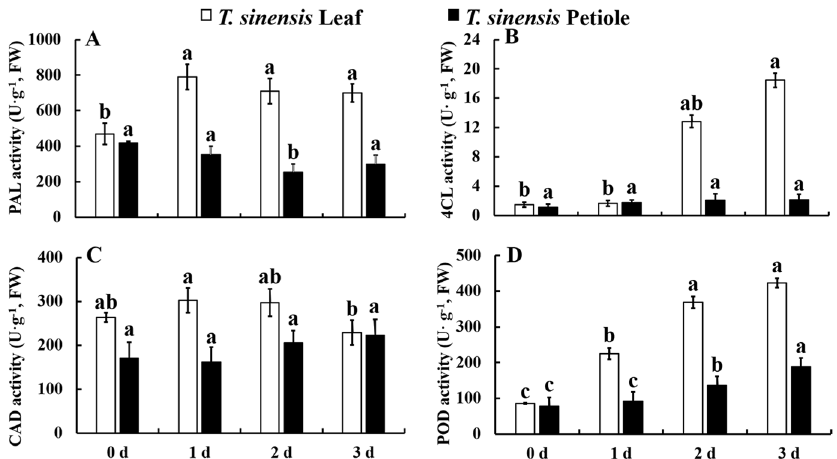
Figure 2. Analysis of enzyme activity of T. sinensis buds during storage in lignin metabolic pathways. ( A ): The PAL activity of red T. sinensis buds during storage; ( B ): The 4CL activity of red T. sinensis buds during storage; ( C ): The CAD activity of red T. sinensis buds during storage; ( D ): The POD activity of red T. sinensis buds during storage. Different lowercase letters on the column indicates significant differences among different treatments ( p < 0.05).